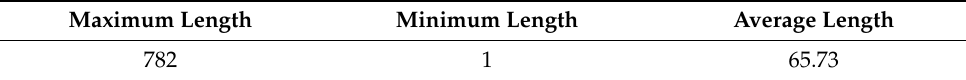
Table 2. Statistical indexes of POI collections in the urban functional